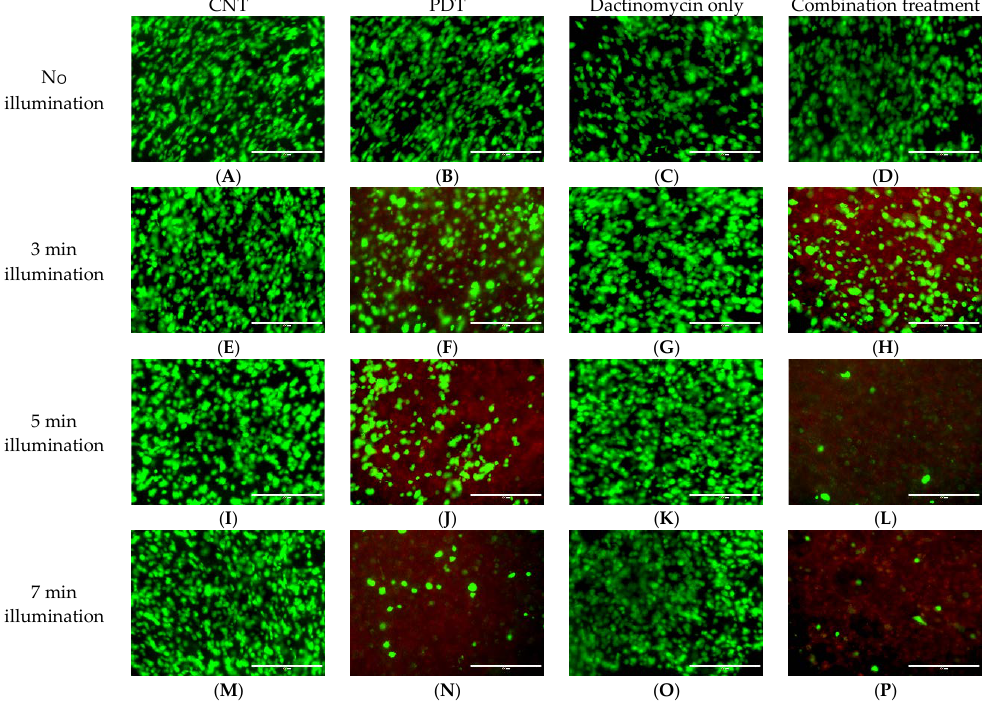
Figure 7. Live-Dead images of SKOV3 3D cultures post PDT (0.3 µg/mL) ( B , F , J , N ), dactinomycin only (1 nM) ( C , G , K , O ) and combination treatment ( D , H , L , P ) using different light conditions, and ( A , E , I , M ) without light. The cultures were treated using a blue lamp at wavelength of 420 nm and light power of 7 mW/cm 2 . The total light doses used were 1.26 J/cm 2 (3 min), 2.1 J/cm 2 (5 min) and 2.94 J/cm 2 (7 min). Live-Dead assay was applied 48 h after illumination. To stain the live (green) and dead (red) cells, the 3D constructs were incubated with a solution containing Calcein-AM (live) and Ethidium homodimer-1 (dead). The scale bar presented in each image is 400 µm.